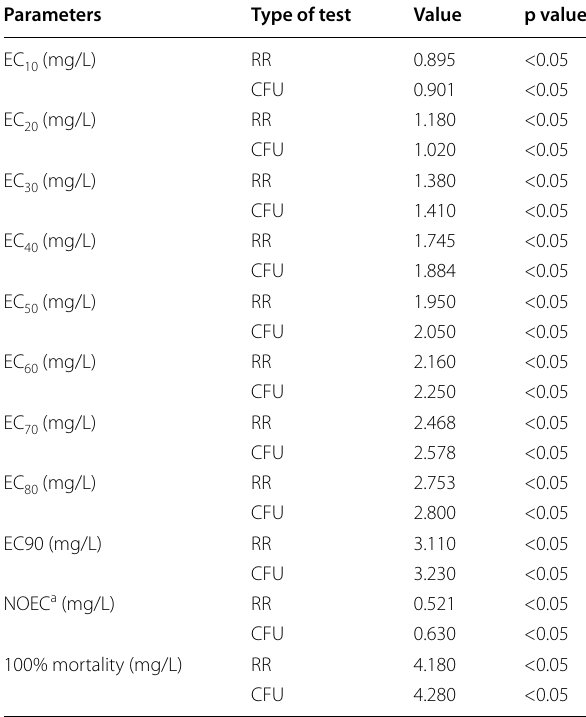
Table 3 The result of acetamiprid effect concentration in Resazurin reduction and colony forming unit